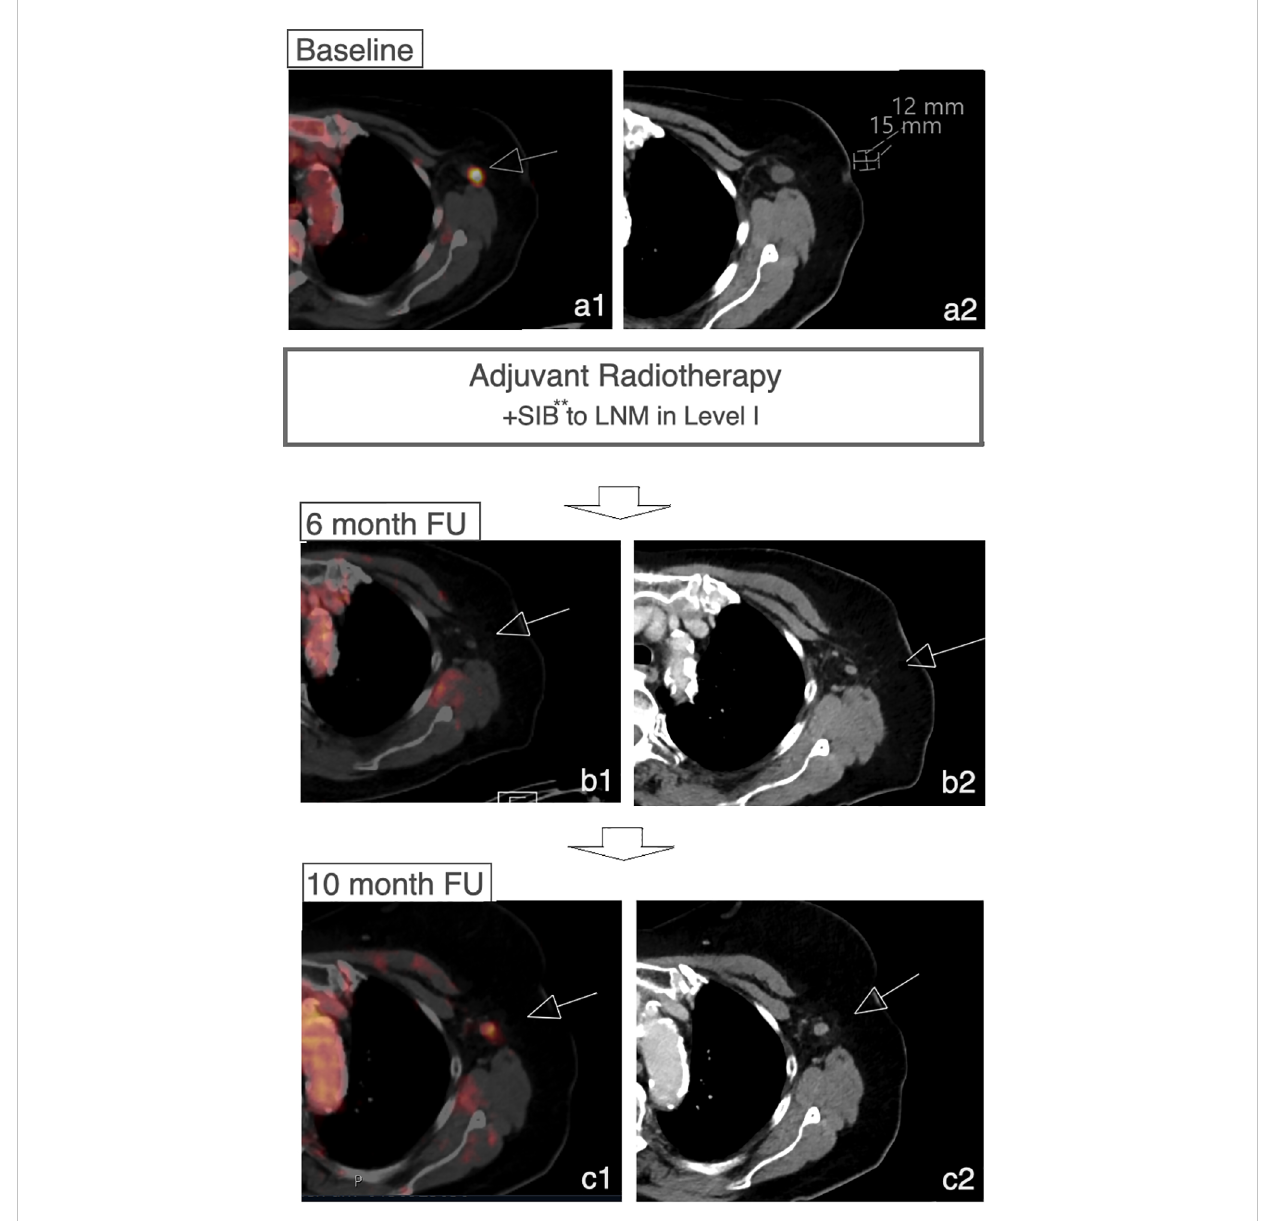
FIGURE 4 Recurrence within LN-SIB. Case of a patient with initial response to LN-SIB of a LN in level I 3 months after RTx and recurrence 10 months after RTx. **Dose 58.8 Gy in 28